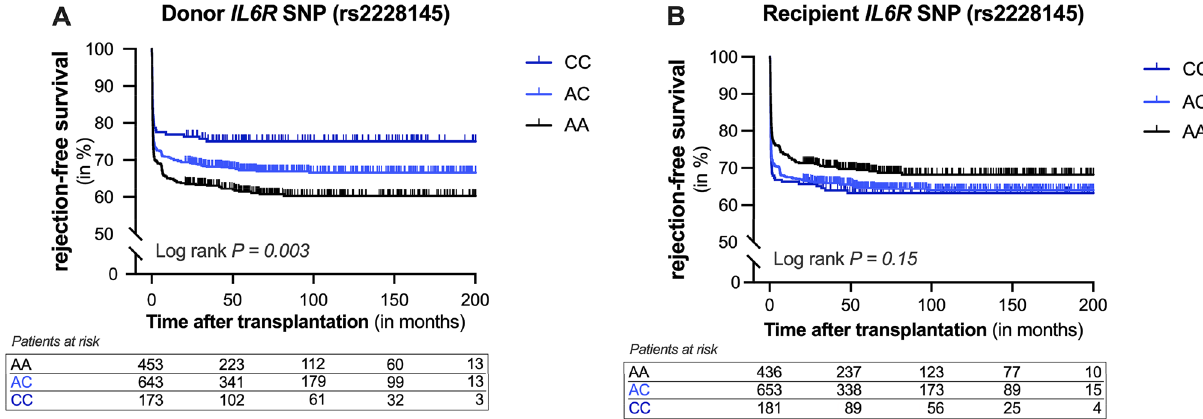
Figure 2. Kaplan–Meier curves for rejection-free survival of kidney allografts according to the presence of the interleukin-6 receptor variant in the donor or recipient. Cumulative rejection-free survival of renal allografts according to the presence of the Asp358Ala variant in IL-6 receptor ( IL6R , rs2228145 A > C, previously rs8192284) in ( A ) the donor, and ( B ) the recipient. Log-rank test was used to compare the incidence of biopsy- proven rejection between the groups.